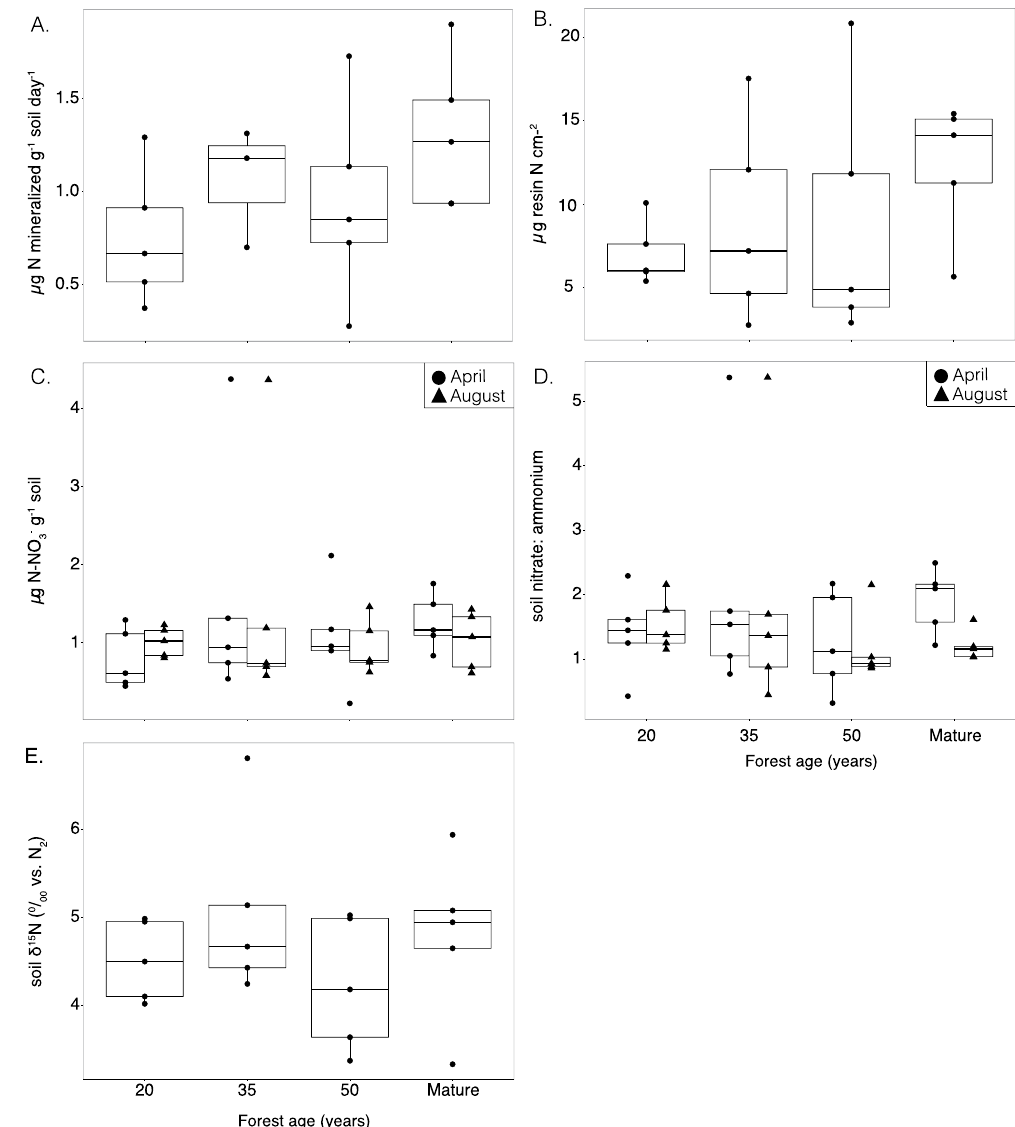
Figure 1. Indicators of nitrogen availability along secondary successional forest chronosequence. ( A ) Nitrogen mineralization rate, ( B ) in-situ resin extractable nitrate concentration, ( C ) instantaneous KCl-extractable soil nitrate concentration. and ( D ) soil nitrate: ammonium, ( E ) soil δ 15N ( 0 / 00 vs. N 2 ). Boxplot with each replicate plot indicated as a point (n = 5, except for mineralization rates in 35-year old forests, n = 3). Data is shown as boxplot with the median value indicated by the band near the middle of the box, the first and third quartiles are the top and bottom of the box, respectively, the maximum and minimum values excluding outliers are the whiskers. Data in panel C and D show data from two sampling times; April = closed circles and August = closed triangles. The effect of forest age is not significant for all N indicators examined (p > 0.05; K-W